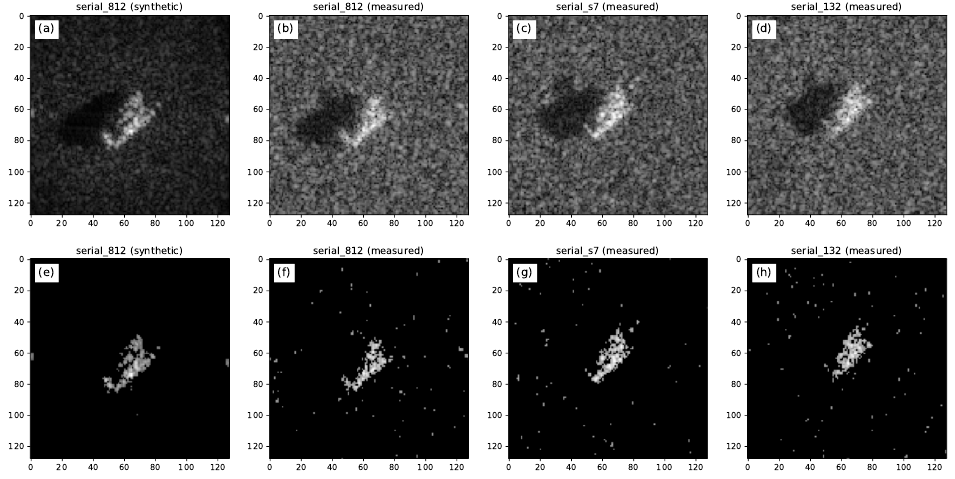
Figure 18. ( a ) Synthetic data chip of a T-72 tank (SN 812). Measured data of a T-72 tank of serial number: ( b ) 812, ( c ) S7 and ( d ) 132. Image reconstructed with 400 Scattering Centers extracted from ( e ) the synthetic data of the T-72 tank of serial number 812 and the measured data of the T-72 tanks of serial numbers ( f ) 812, ( g ) S7 and ( h ) 132.